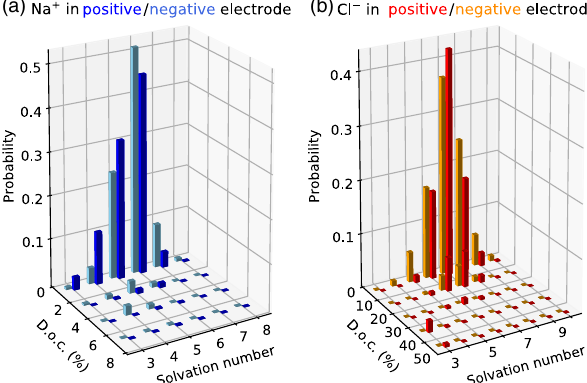
FIG. 5. Joint distribution of solvation number and d.o.c. of Na þ (left panel) and Cl − (right panel) ions in positive (dark blue, red) and negative (light blue, orange) electrodes, for the 1.0 M system. The histograms correspond to the discrete values of the solvation number and to finite intervals of the continuous d.o.c. (of width 2% and 10% for Na þ and Cl − ,